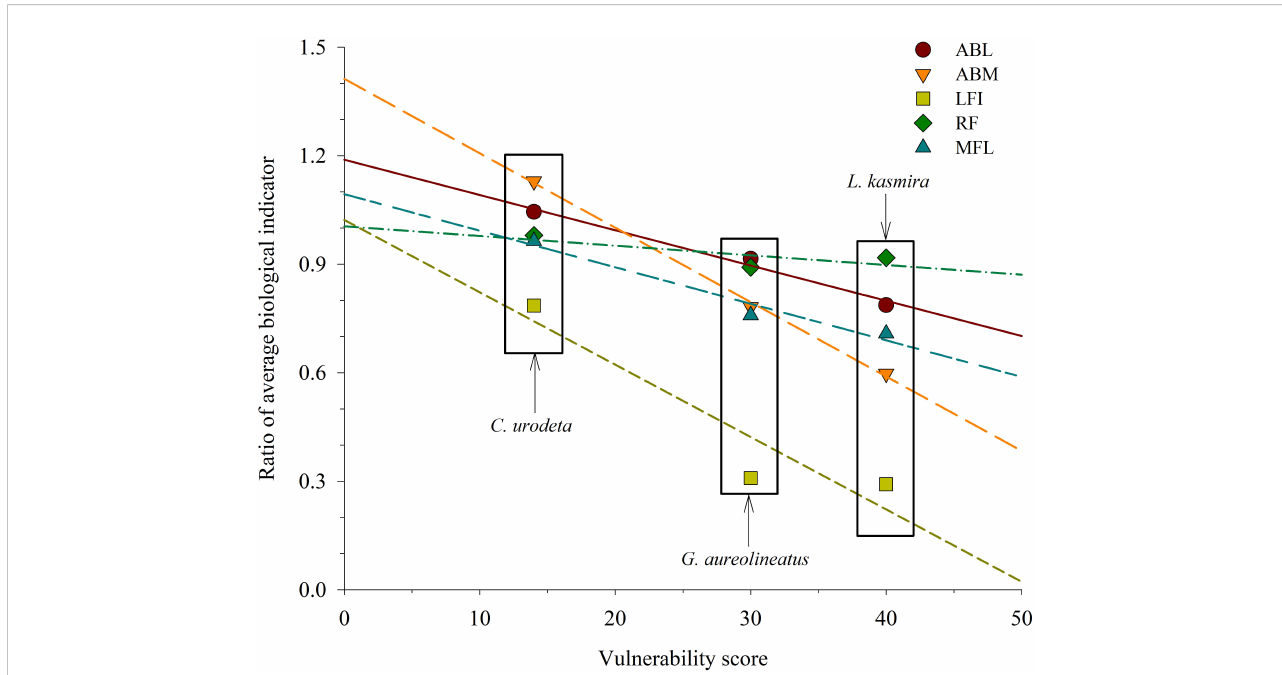
FIGURE 5 Linear fi t between ratios of average biological indicators of Lutjanus kasmira , Gnathodentex aureolineatus and Cephalopholis urodeta in 2016 – 2019 to those in 1998 – 1999 and vulnerability score in the Yongshu Reef, South China Sea. ABL = -0.0097*VS + 1.1889 ( R 2 adj = 0.9676, p < 0.05), ABM = -0.0206*VS + 1.4123 ( R 2 adj = 0.9962, p < 0.05), LFI = -0.0200* VS + 1.0222 ( R 2 adj = 0.7506, p > 0.05), RF = -0.0027* VS + 1.0046 ( R 2 adj = 0.1970, p > 0.05), MFL = -0.0101* VS + 1.0935 ( R 2 adj = 0.9189, p >